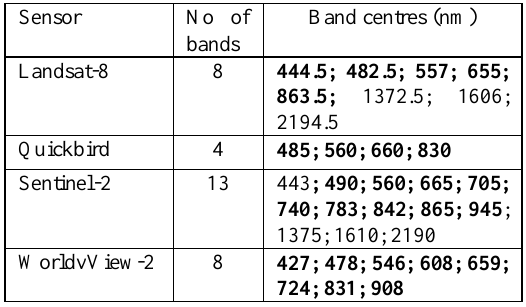
Table1. Band characteristics of the four multispectral sensors used in the analysis. The bold shows the bands used in this analysis